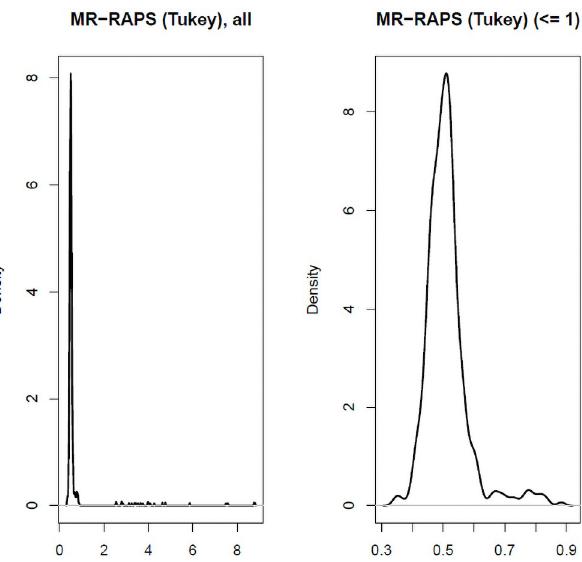
Fig 14. Distribution of MR-RAPS estimates at sample size = 50,000 when the data were generated under the LAD regression model. (A = Left: all estimates, B = Right: estimates less than